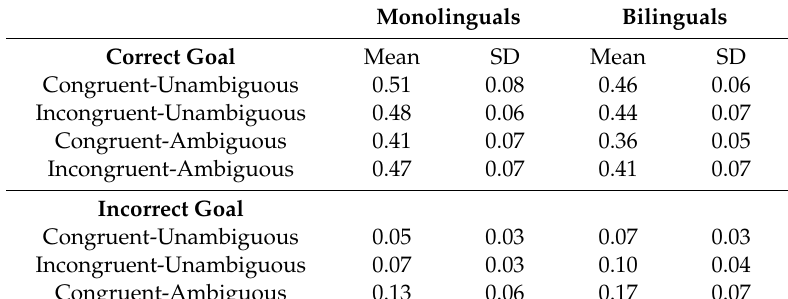
Table 2. Mean proportion of fixations by group, condition, and object.